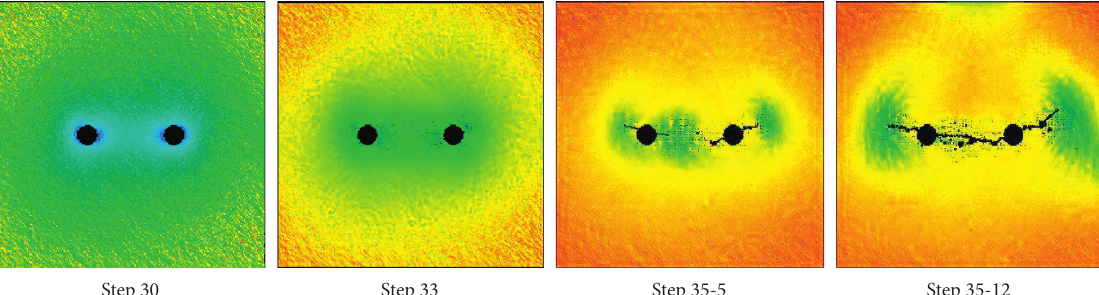
Figure 2: Hydraulic fracture evolution of double-wellbore model ( m � 2, K �